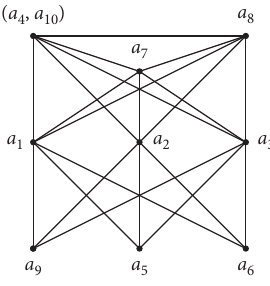
Figure 2: The graph of G ′